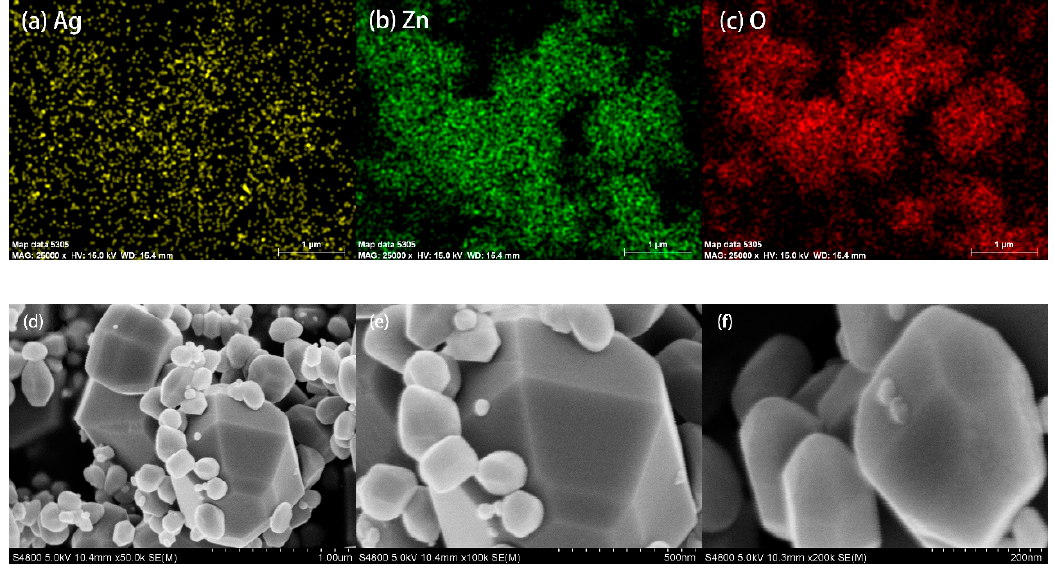
/ ZnO (100:1); ( d – f ) SEM images of Ag / ZnO Figure 9. ( a – c ) EDS mapping of Ag/ZnO (100:1); ( d – f ) SEM images of Ag/ZnO (100:1). Figure 9. ( a – c ) EDS mapping of Ag